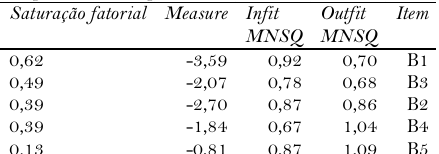
Tabela 6 Estatísticas do Fator 1, Extraído por Análise de Componentes Principais dos Resíduos, da Série B Saturação fatorial Measure